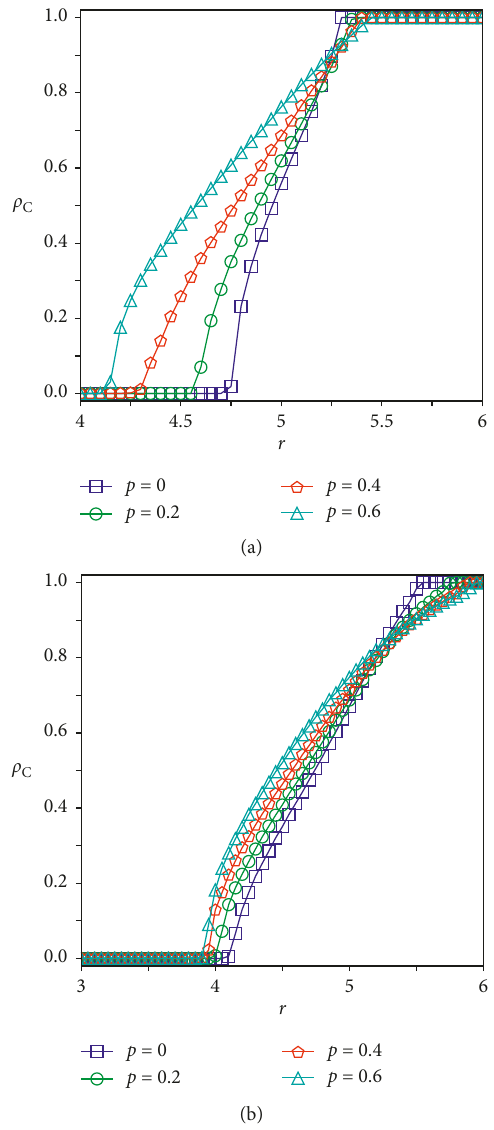
Figure 1: The cooperation level ρ group density p of players on regular square lattice (a) and WS small-world network (b),